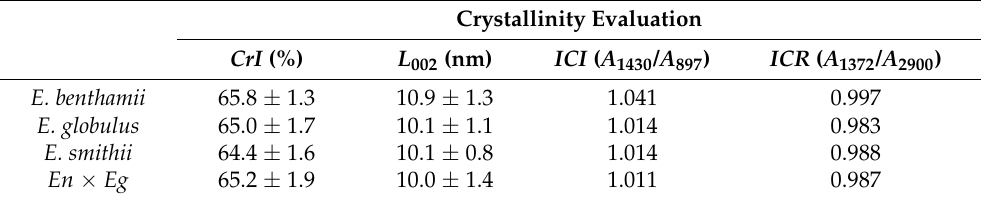
Table 3. Obtaining yield along with apparent crystallinity degree ( CrI ), lateral crystallite size ( L 002 ), infrared crystallinity index ( ICI ), and infrared crystallinity ratio ( ICR ) of CNC obtained from the different eucalyptus species.